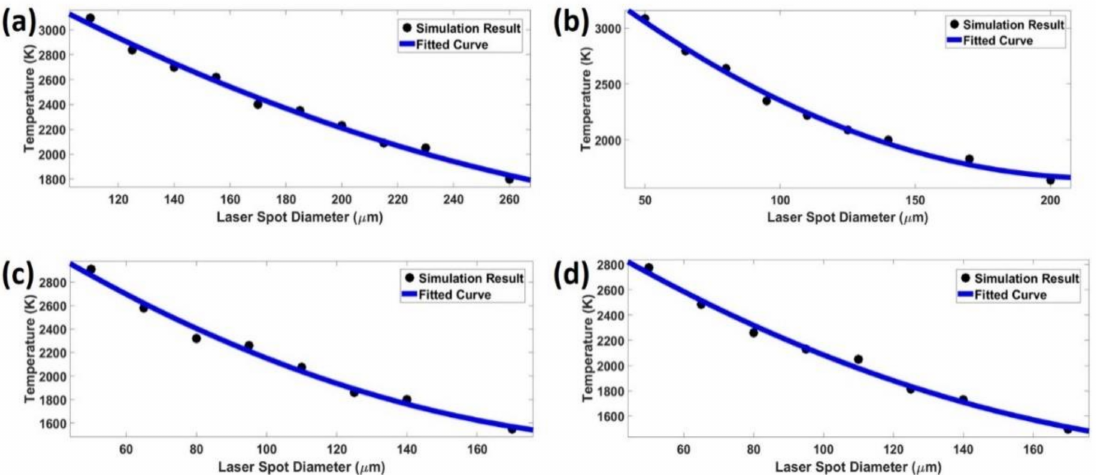
Figure 6. Simulation results and fitted curves of melt-pool temperature at various laser spot diameters with a laser power of 150 W and scanning velocity of ( a ) 0.6 m/s, ( b ) 0.9 m/s, ( c ) 1.2 m/s, and ( d ) 1.4 m/s.